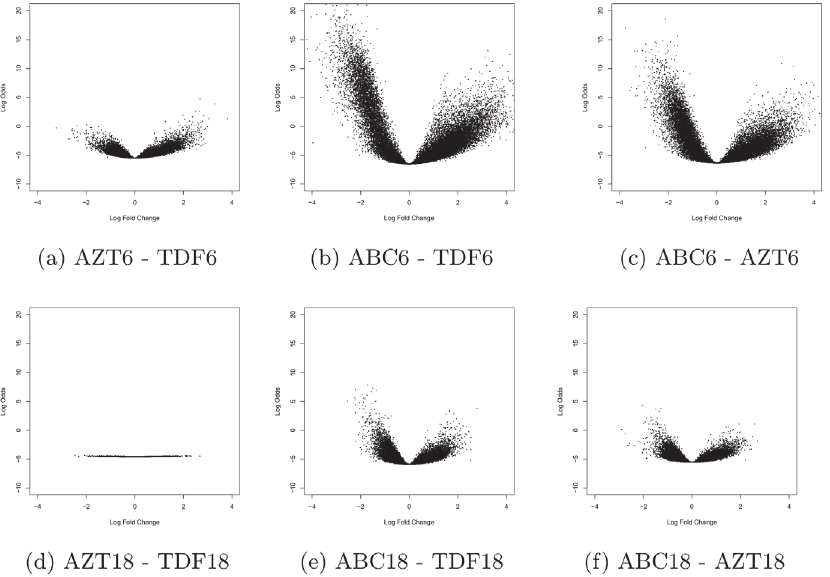
Figure 3. Volcano plot showing significance versus fold changes in the y- and x-axis respectively for the three treatment groups at 6 months on top row (a-c) and 18 months on bottom row (d-f). For each comparison the first term is the numerator and the second